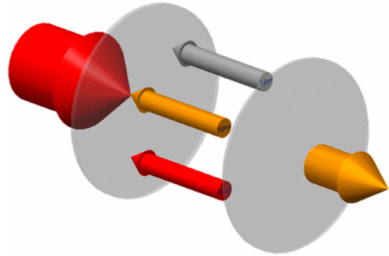
Figure 10. Schematic diagram illustrating the principle of the coupled solution method of cascade lasing for backward